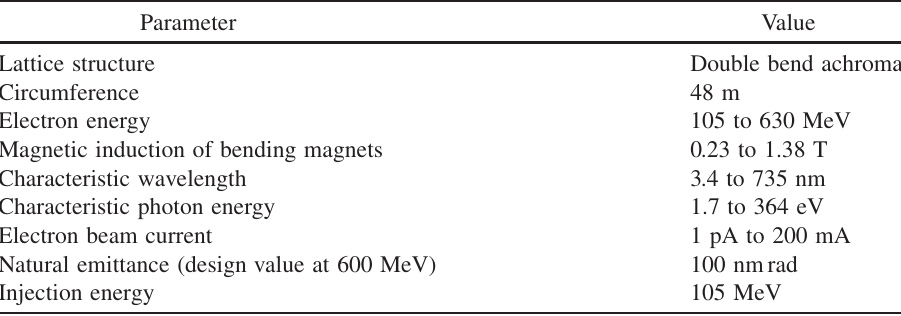
TABLE I. Main MLS parameters.